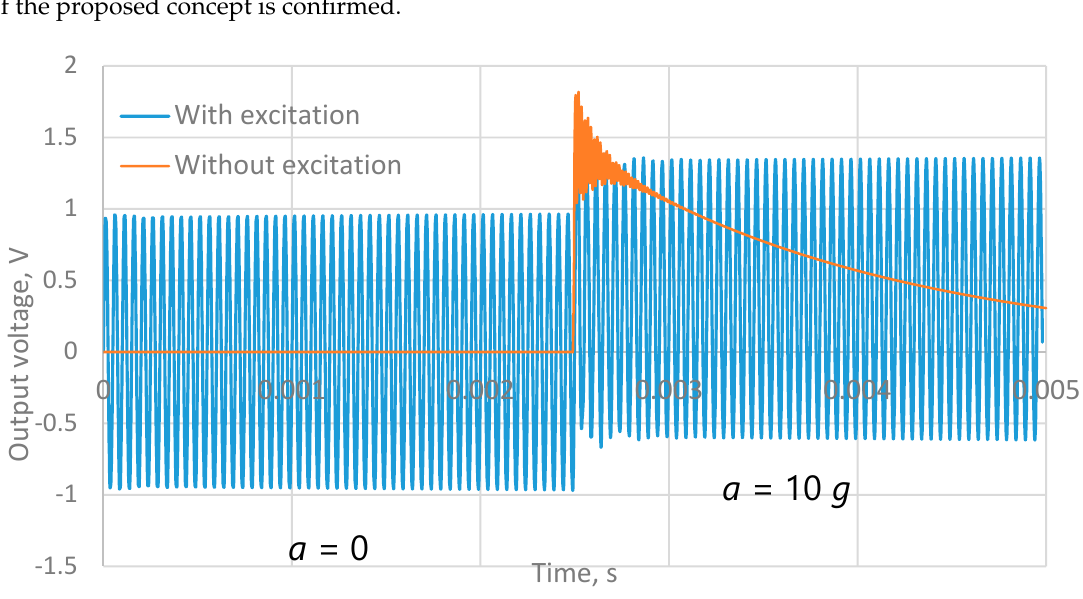
Figure 3. Output signal at different values of acceleration (simulation results).